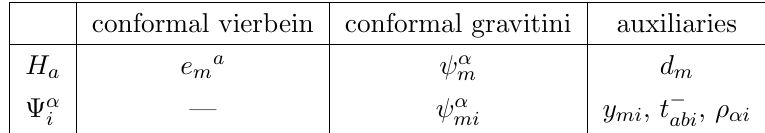
Table 5 . Component spectrum of superspin- 3